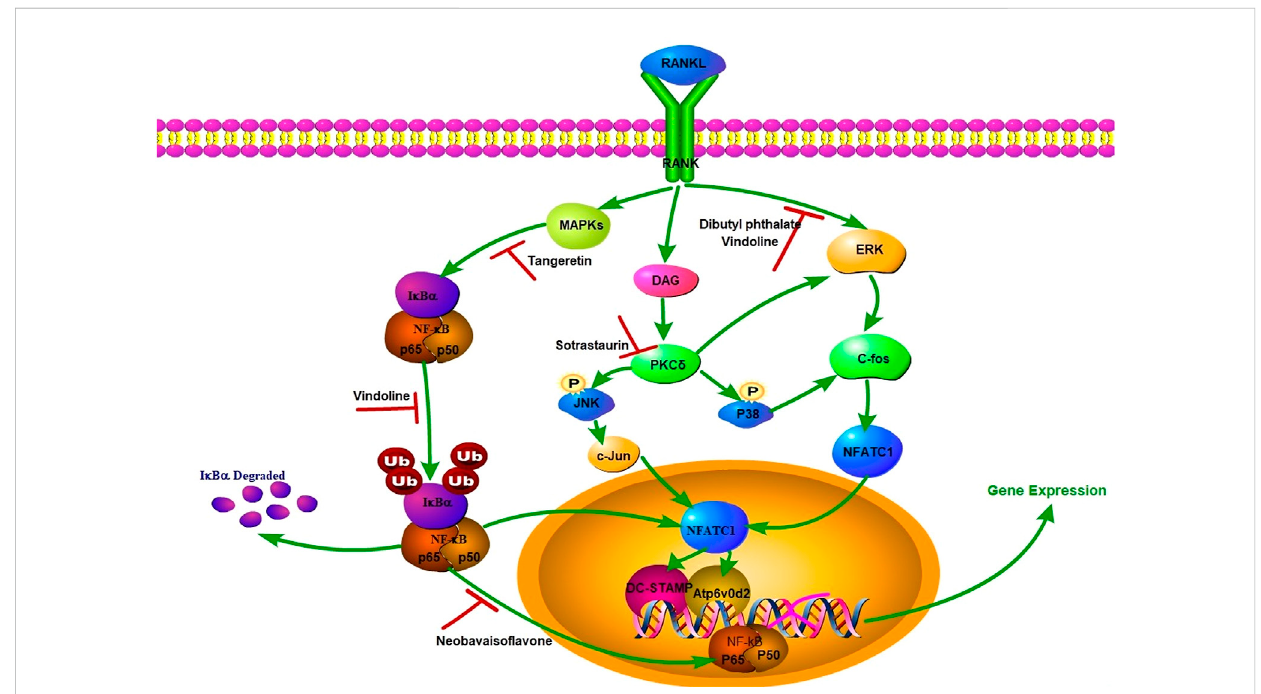
FIGURE 5 RANKL-mediated signaling pathway and natural small molecular compounds with anti-OA